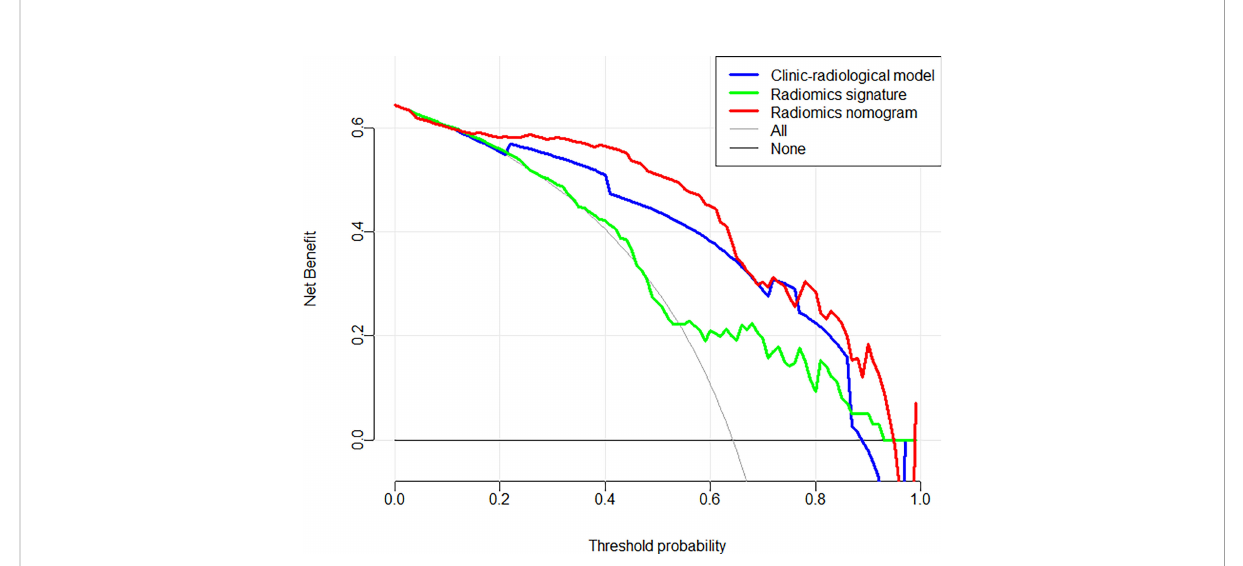
FIGURE 6 Decision curve analysis for each model in predicting Ki-67 expression status for BC